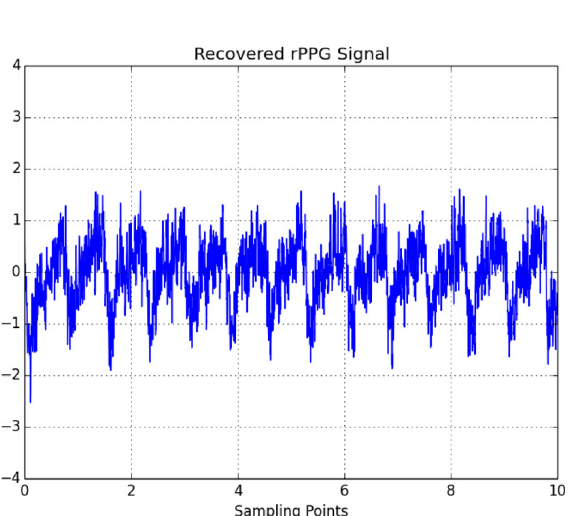
Figure 8. Clean PPG signal and generated signal with Gaussian noise